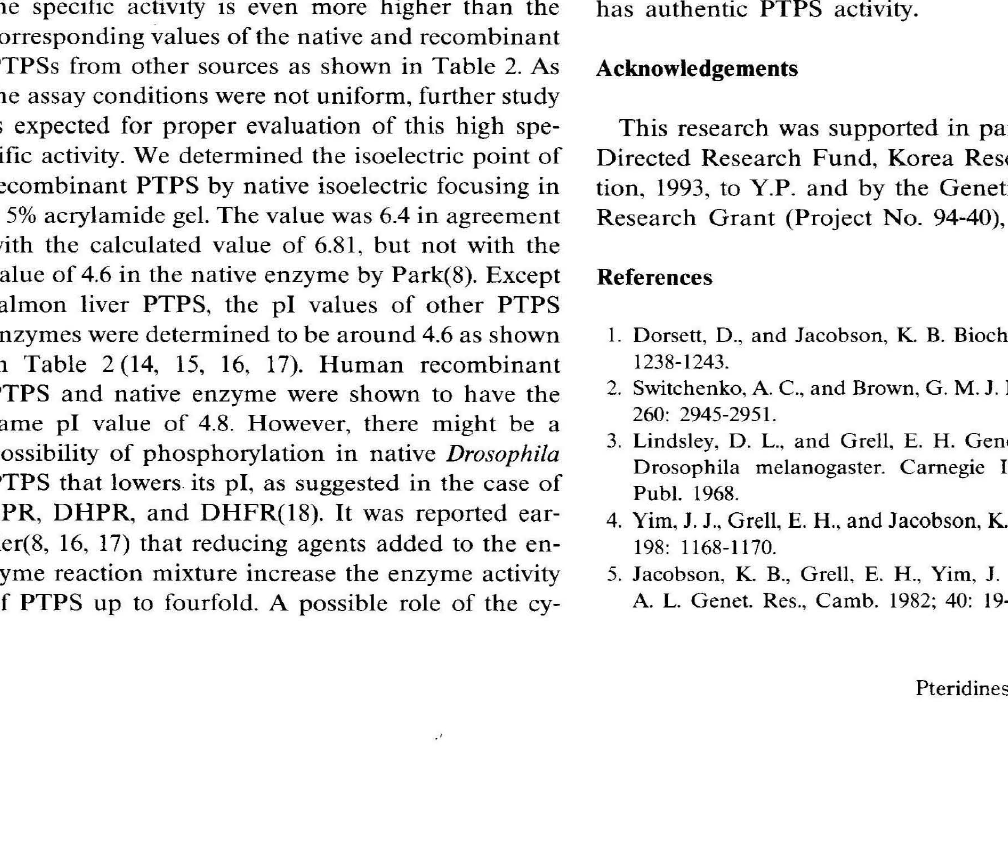
PTPS. Fig. 3 shows the losspf enzyme activity using increasing concentrations of iodoacetamide under non-reducing conditions. The activity was reduced up to 80% at 100 mM